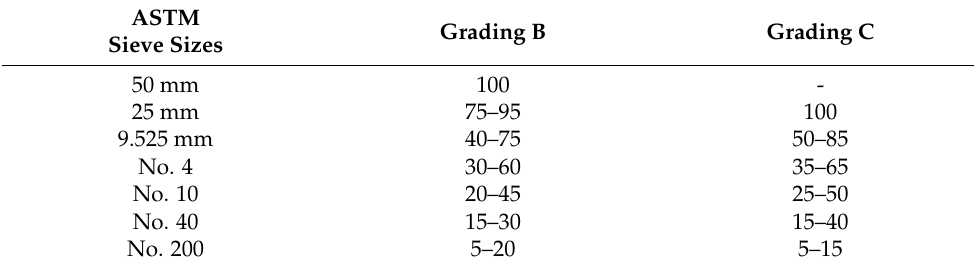
Table 1. Grading requirement for samples as per the AASHTO standard.